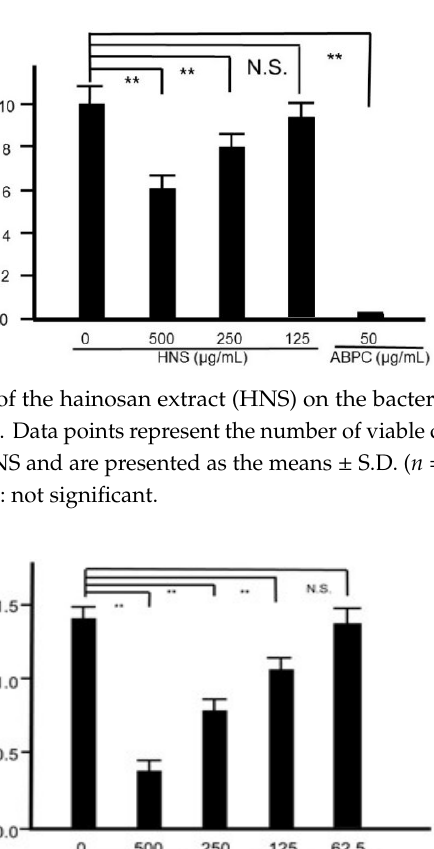
Figure 3. Inhibitory effects of the HNS on the biofilm formation by S.mutans , measured by confocal laser scanning microscopy. S. mutans cells were treated with HNS (500 μg/mL) for 48 h. The biofilms formed were stained with fluorescein isothiocyanate isomer (FITC), and the three‐dimensional findings were obtained from the confocal optical sections.